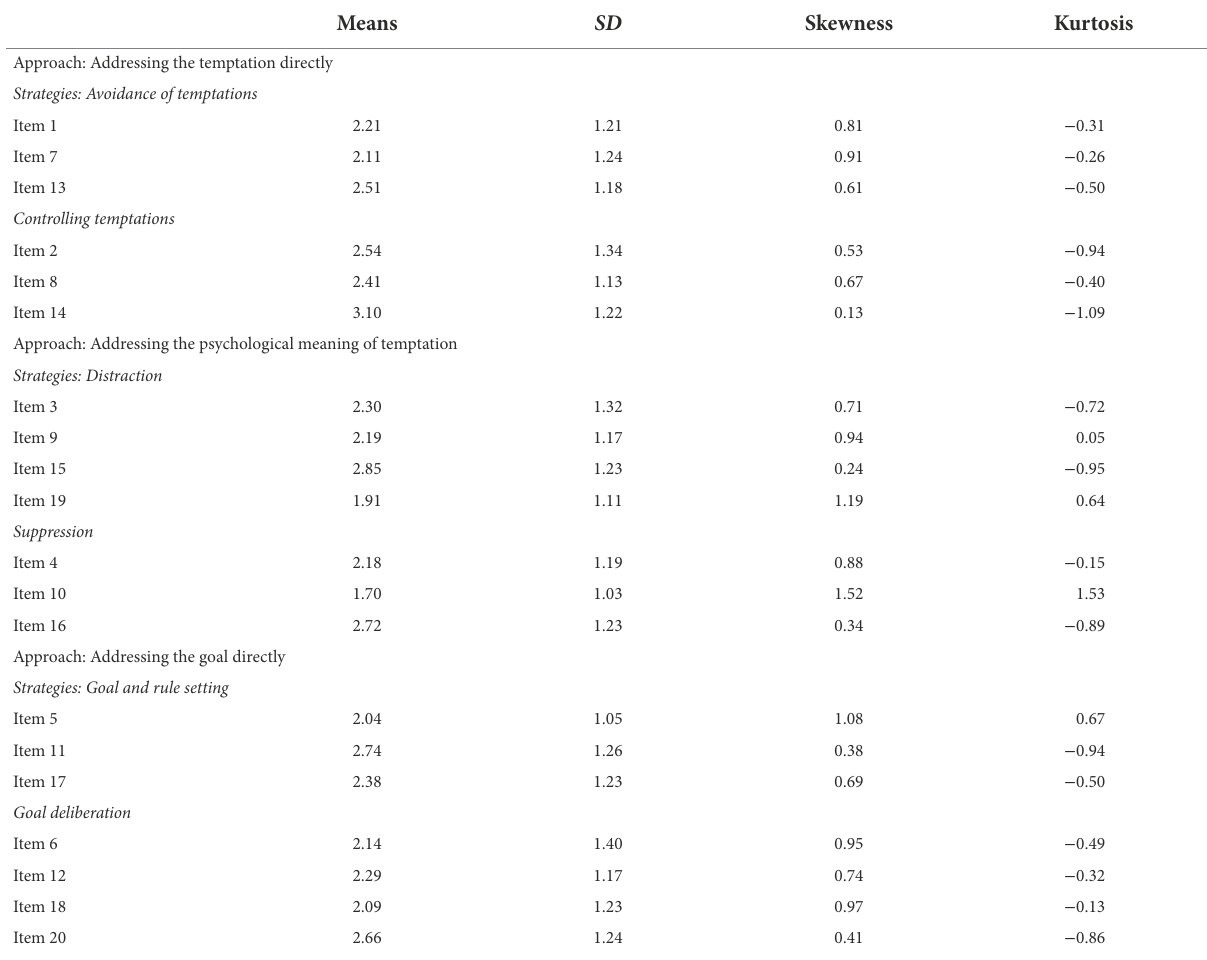
TABLE 1 Means, SDs, skewness, and kurtosis of the selected items. Means SD Skewness